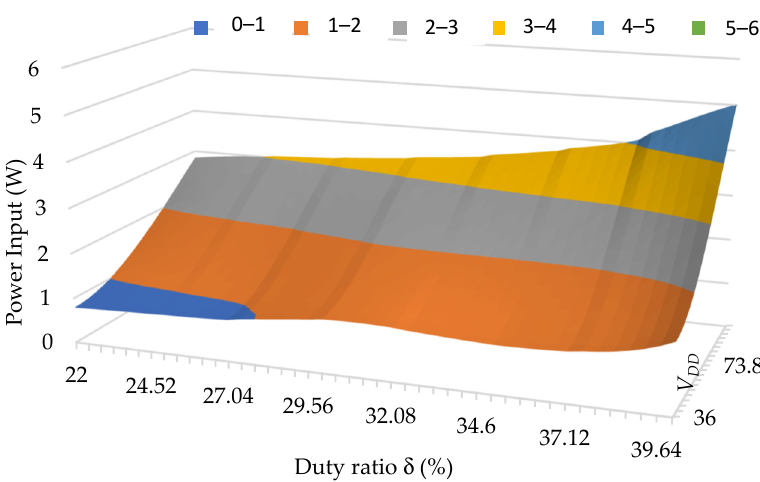
Figure 5. Power input vs. duty ratio % and Input voltage V DD . Step 3. From the given input voltage V DD and the duty ratio δ % calculated in step 2, we determine the switching frequency f o according to the empirical function shown in Figure 6, which is interpolated in [25].